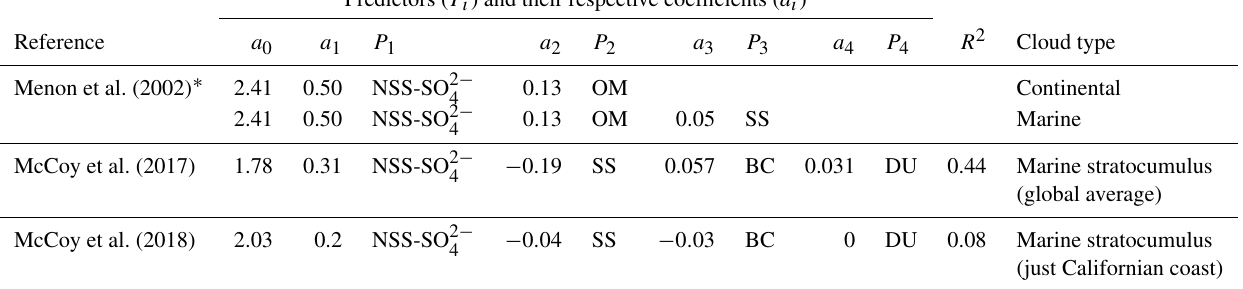
Table 7. Results of multivariable regressions from previous studies that have correlated N d to mass concentrations. The regression cor- responds to a model like Eq. (3). OM represents organic matter, SS represents sea salt, BC represents black carbon, and DU represents dust. Predictors ( P i ) and their respective coefficients ( a i )